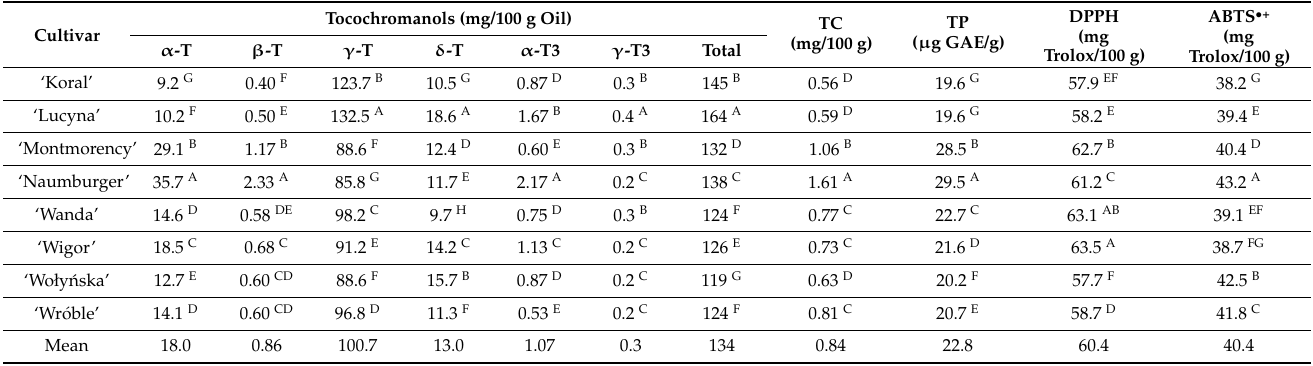
Table 6. Phytochemical compounds with antioxidant effects in sour cherry kernel